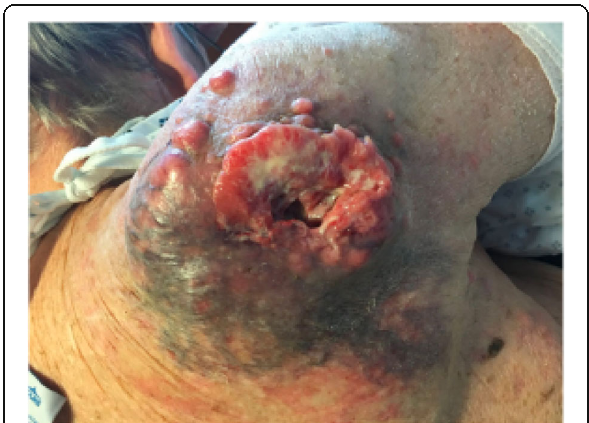
Fig. 4 Clinical image showing necrotic and fungating shoulder